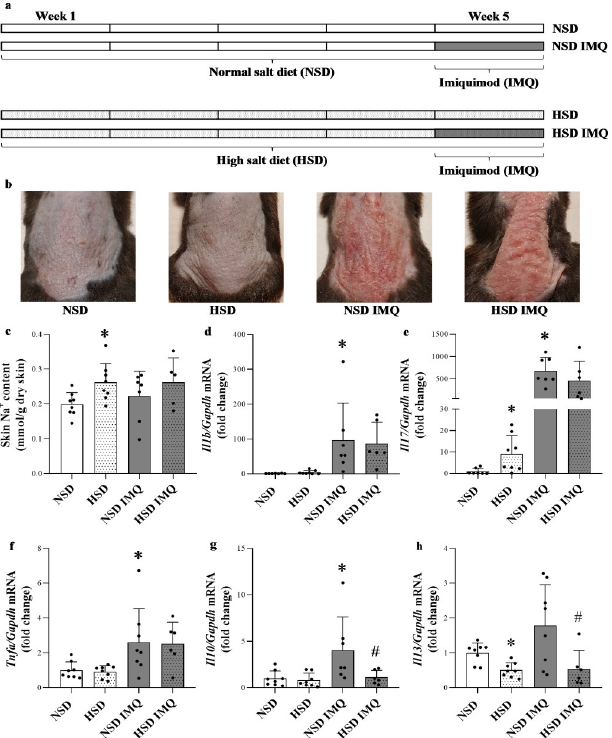
Fig 1. Effect of high salt diet on dermal inflammation in IMQ-treated and control mice. ( a ) Mice were kept on NSD or HSD for 5 weeks and on the last 5 days of the dietary regime the mouse model of IMQ-induced dermatitis was performed on the indicated group of animals. ( b ) 5 days of IMQ (62.5mg with 5% imiquimod cream) or vaseline treatment applied to NSD and HSD mice resulted in the inflammation of the back skin of mice. ( c ) The skin Na + content was measured by flame photometry following tissue digestion. ( d-h ) The dermal mRNA expression of Il1b , Il17 , Tnfa , Il10 and Il13 in the skin tissues of mice was determined by real-time PCR in comparison with Gapdh . Data were normalized and presented as the ratio of the mean values of the control group. Values were expressed as mean +SD. Dots represent individual values. n = 6–8 in each group; � p < 0.05 vs. NSD; #p < 0.05 vs. NSD IMQ; (Unpaired t- test (c,f,h), Mann-Whitney U-test